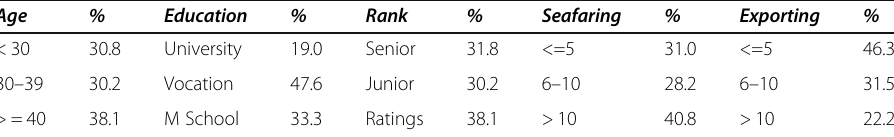
Table 1 Profiles of respondents by age, education, rank, seafaring and exporting length (years) Age % Education % Rank % Seafaring < 30 30.8 > = 40